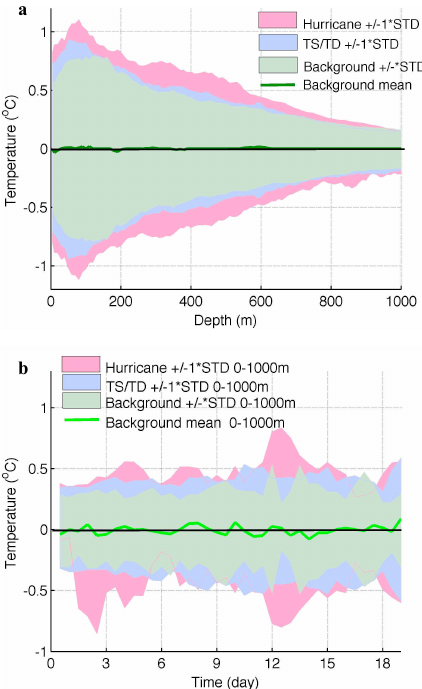
Figure B3. Bootstrap analyses of background noise. (a) Standard errors at different depth versus sample numbers with colors denot- ing different depths. (b) Standard errors at different times versus sample numbers with colors denoting different times. Solid lines are the results from using the whole NoTC pairs data set, and the dots show the same results for the TC-affected